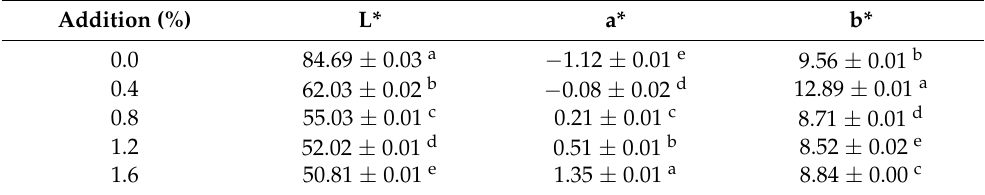
Table 2. Color analysis of 3D-printed processed cheese with different apple polyphenol content.